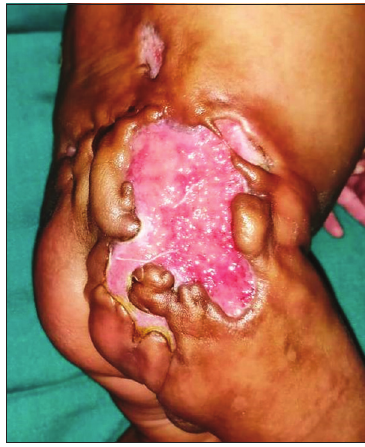
Figure 2: Large raw area few days after debridement